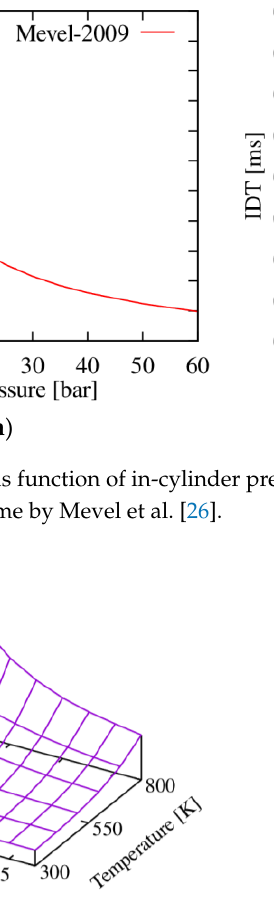
Figure 1. LFS-simulated trend versus experimental data at 1 bar and 303 K: ( a ) For equivalence ratios ϕ between 0 and 4. ( b ) For equivalence ratios ϕ between 0.2 and 1.2 — Mevel-2009 [26]: 14 species and 42 reactions. Model for hydrogen/air combustion; Ranzi-2014 [24]: 21 species and 62 reactions. Model for Syngas (H2/CO)/air combustion; Alekseev-2015 [25]: 11 species and 27 reactions. Model for hydrogen/oxygen combustion; GRI-Mech 3.0 [29]: 53 species and 325 reactions. Model for natural gas combustion; Exp. Dayma-2014 [27]. Figure 2. IDT trend as function of in-cylinder pressure: ( a ) 900 K and ( b ) 1200 K — equivalence ratio ϕ = 0.5. Kinetic scheme by Mevel et al. [26].